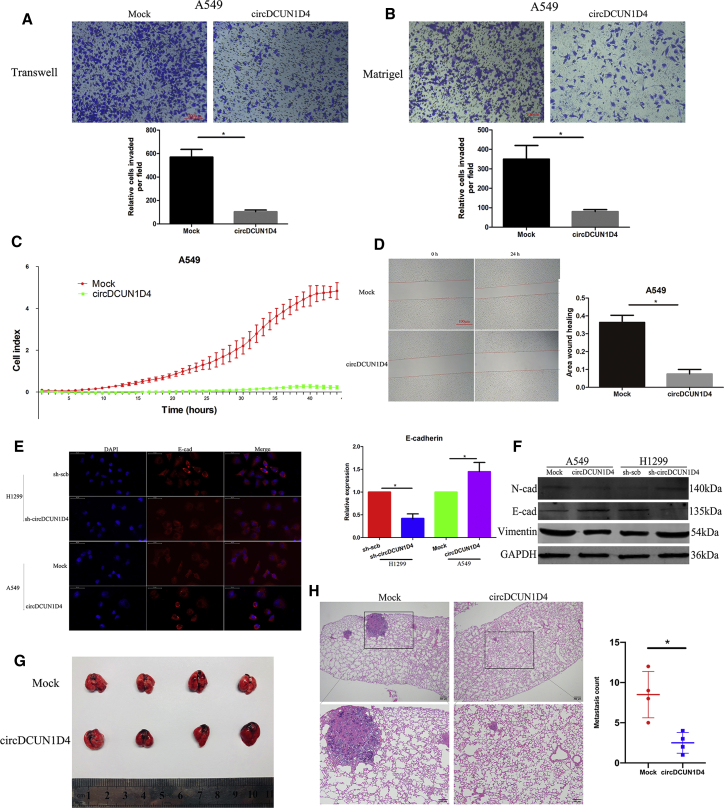
circDCUN1D4 suppresses the invasion and metastasis of cancer cells in vitro and in vivo(A and B) Representative images (upper panel) and quantification (lower panel) of Transwell and Matrigel assays, respectively, showing the invasion of A549 cells stably transfected with empty vector (mock) and circDCUN1D4 (mean ± SD, n = 4). Scale bars, 100 μm. (C) Cell migration in real time was analyzed by the xCELLigence RTCA (mean ± SD, n = 4). (D) Representative images of the wound-healing assay showing the metastasis of A549 cells stably transfected with empty vector (mock) and circDCUN1D4 (mean ± SD, n = 4). Scale bar, 100 μm. (E) Representative images (left panel) and quantification (right panel) of the immunofluorescence staining assay showing the expression of E-cadherin (E-cad) in A549 and H1299 cells stably transfected with mock, circDCUN1D4, scramble shRNA (sh-scb), or sh-circDCUN1D4 vectors (mean ± SD, n = 4). (F) Western blot indicating the expression of N-cadherin (N-cad), E-cad, vimentin, and GAPDH in total lysates of A549 and H1299 cells stably transfected with mock, circDCUN1D4, sh-scb, or sh-circDCUN1D4 vectors. (G) Images of dissected mouse lungs after tail-vein injection of A549 cells stably transfected with mock and circDCUN1D4 vectors (n = 4 for each group). (H) H&E staining of pathological sections (left panel) and the quantification of metastasis count (right panel). Student’s t test and analysis of variance compared the differences in (A–D) and (H). ∗p < 0.05 versus mock or sh-scb.